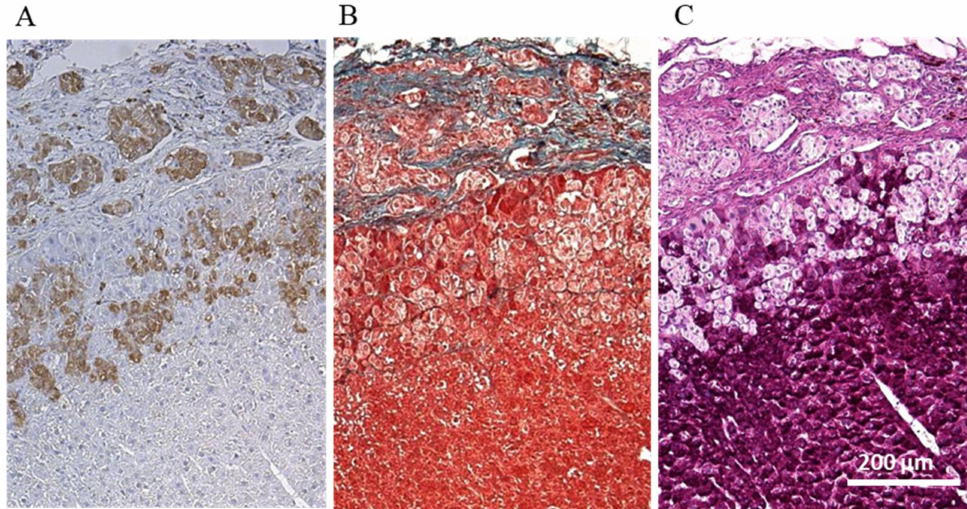
Figure 6. Histological analyses of islets engrafted on liver surface. ( A ) Insulin (brown), ( B ) Elastica- Masson staining to clearly distinguish connective tissues such as elastic fibers (grayish green), and ( C ) Periodic acid-Schiff staining to identify the liver parenchyma